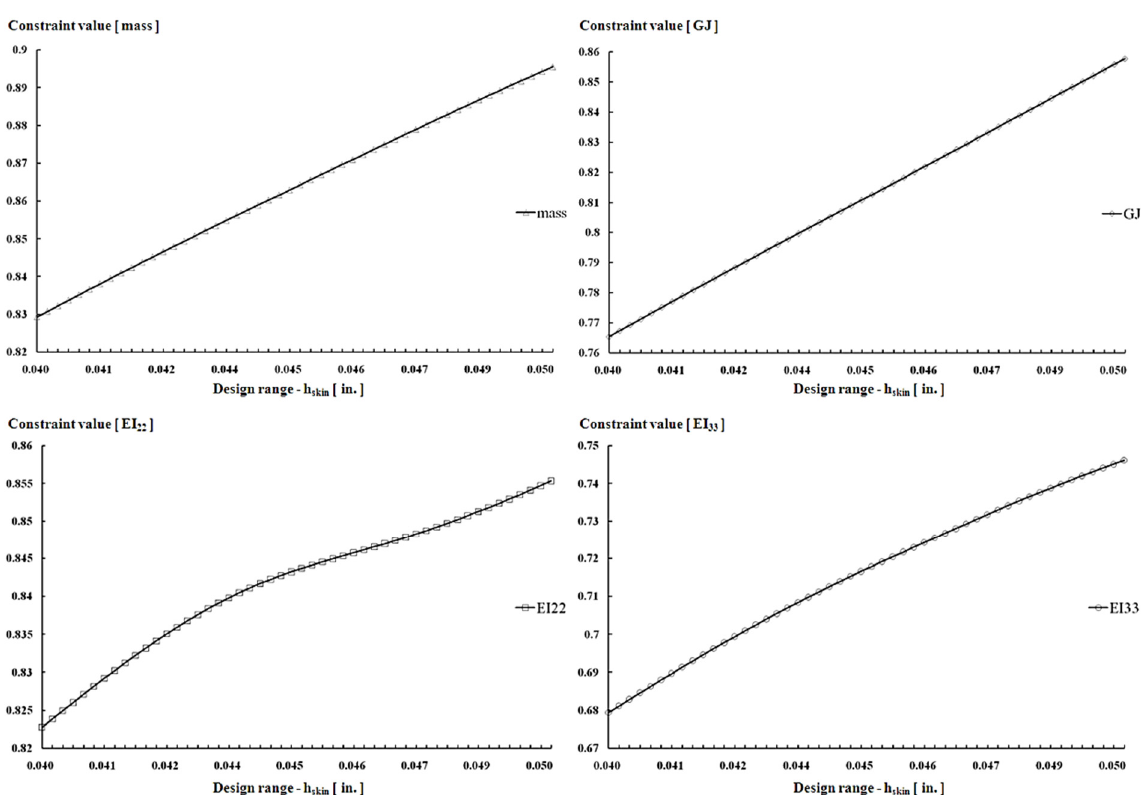
Figure 8. Meta-models for design variable—h skin .